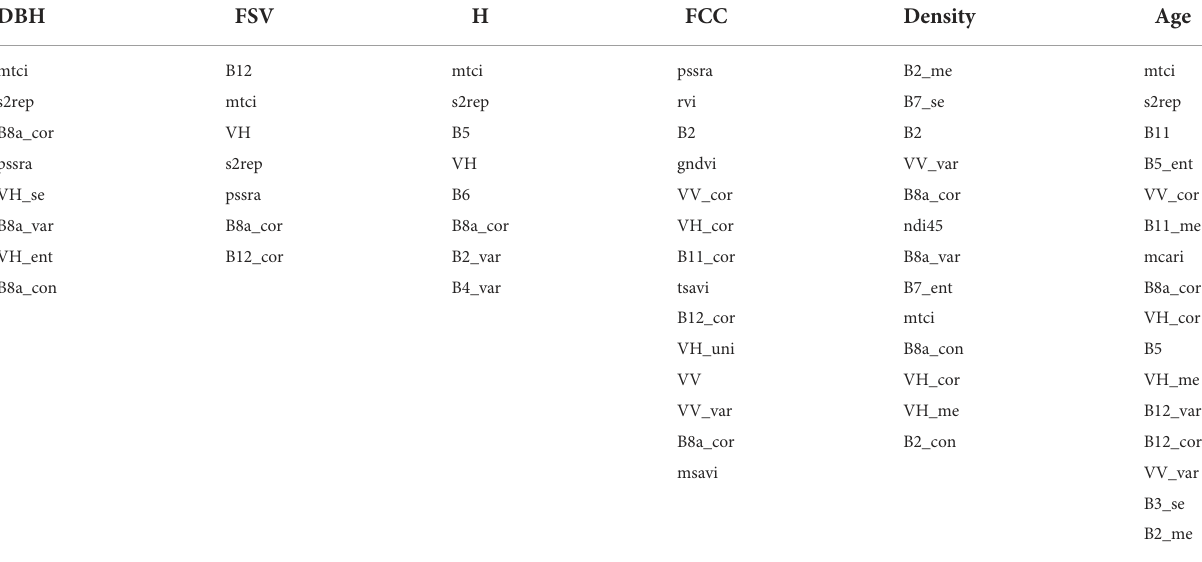
TABLE 6 The optimal variables set related to each forest parameter.